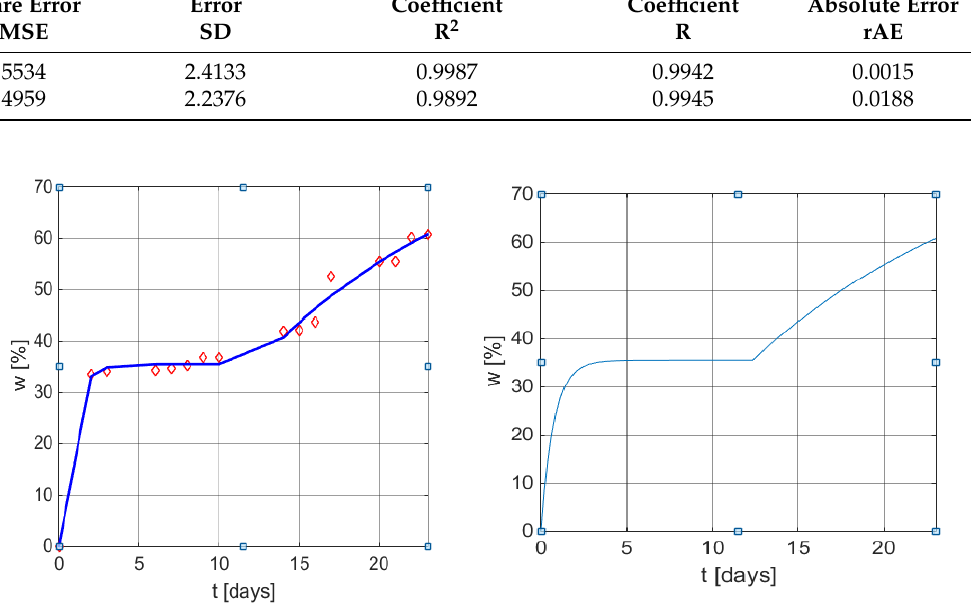
Figure 4. Graphical results of weight loss profile obtained by using the mathematical model (6) and (9). Left: measured values vs. values obtained from Equation (13) with function plot. Right: w(t) curve using model (9) with the same parameters as in (13). Table 4. Statistical indicators—comparative data using models (4) and (6).